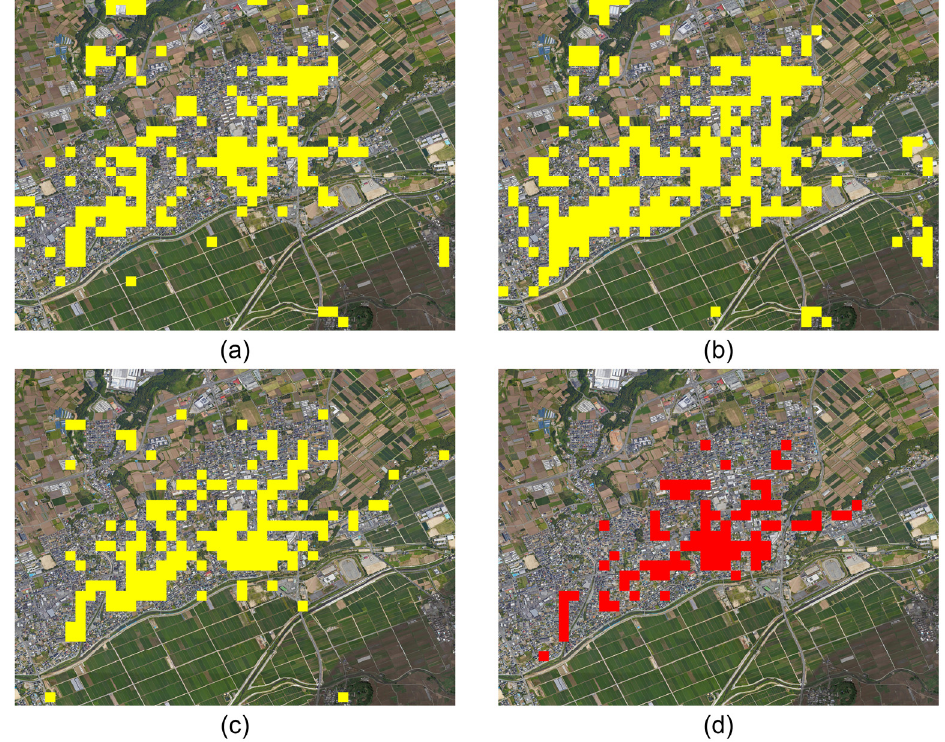
Figure 7. The results of grid-based damage map (yellow) derived from ( a ) intensity-based method, ( b ) GLCM-based method, ( c ) proposed LTCHD method, and ( d ) OSM-based reference damage map.